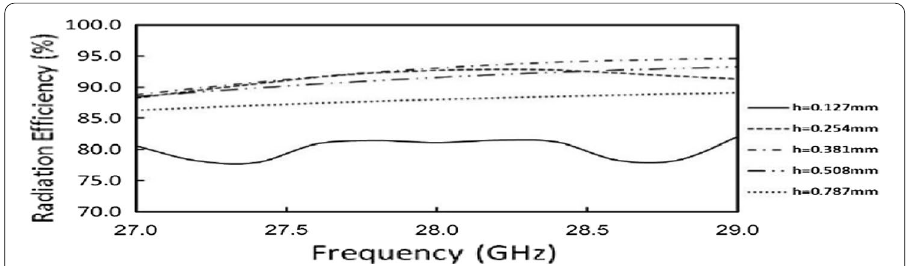
Fig. 5 Simulated radiation efficiency versus frequency at different substrate thickness